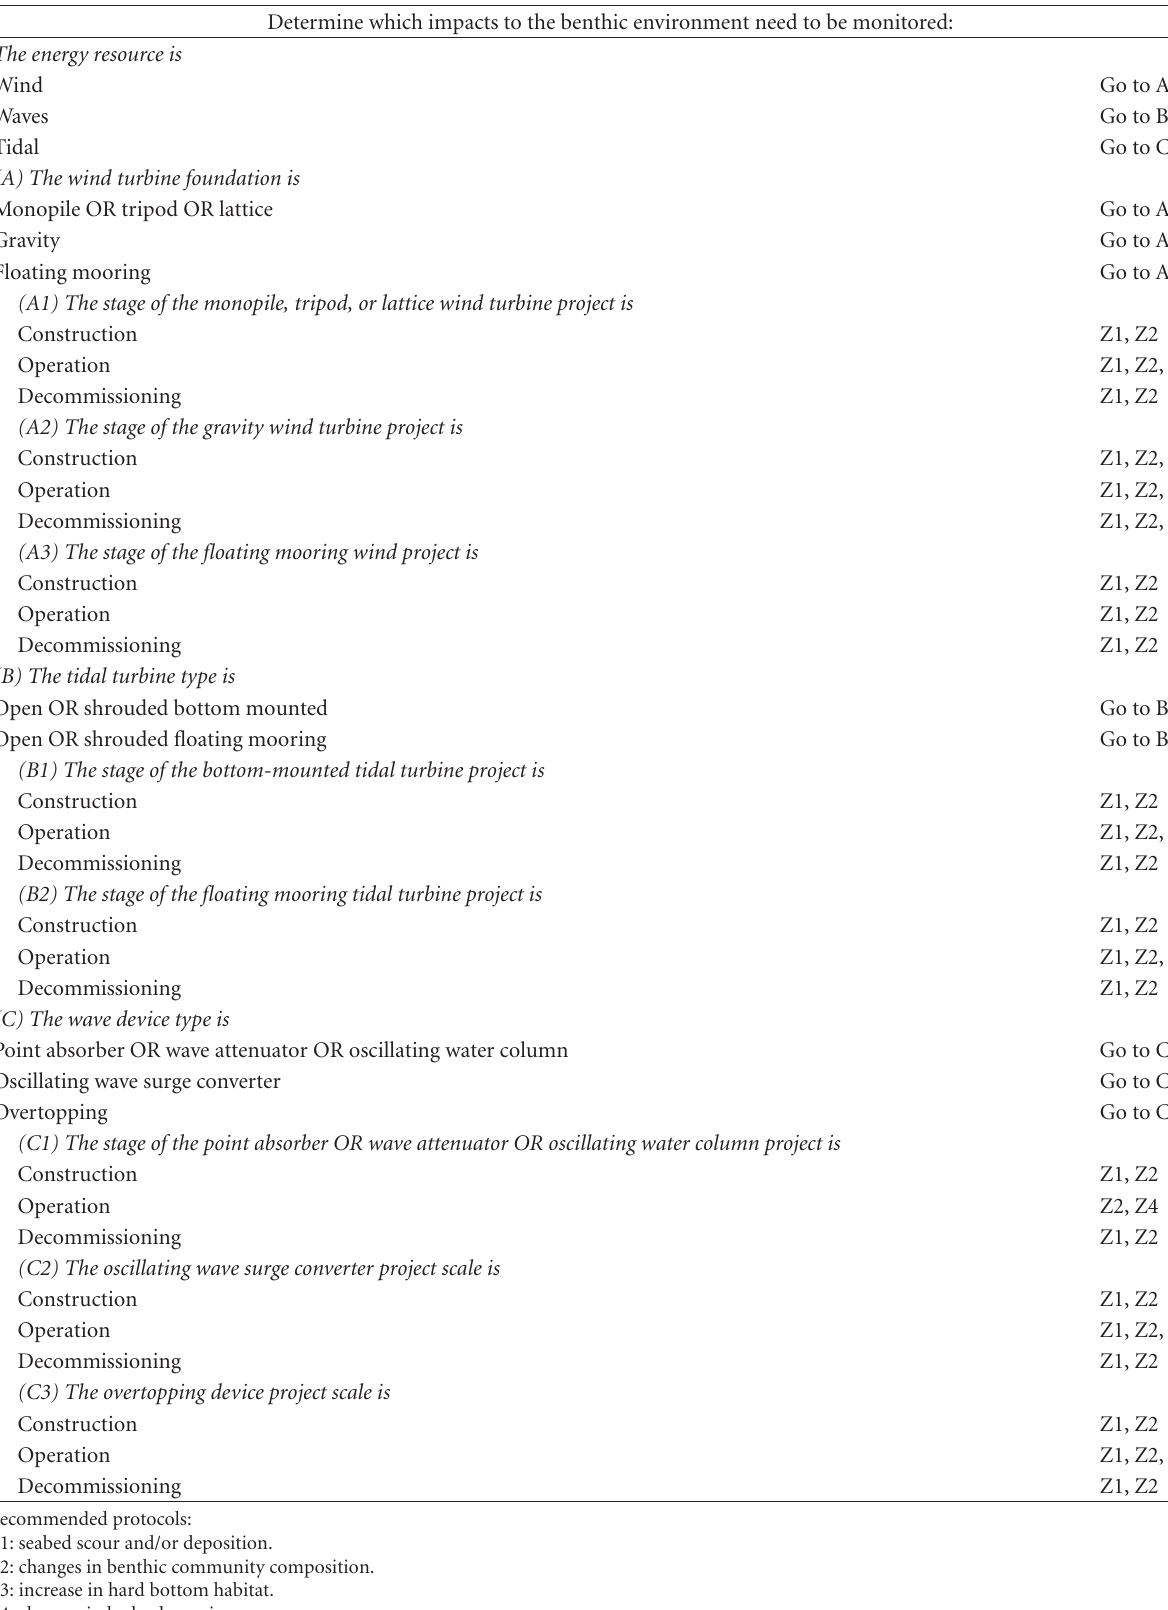
Table 9: Component decision tree for impacts on benthic habitat and resources. The key is followed to obtain a recommended suite of monitoring